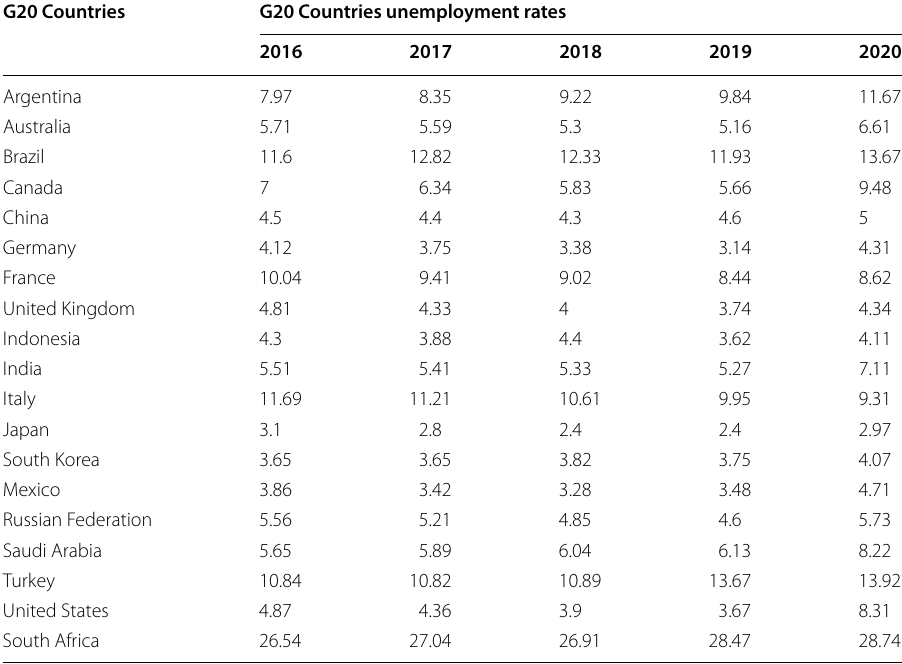
Table 6 G20 countries (excluding EU) unemployment rates G20 Countries